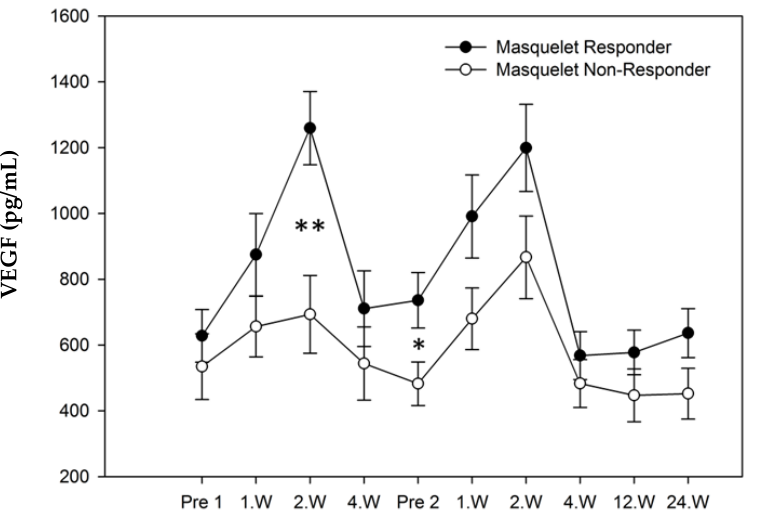
Figure 6. VEGF mean concentrations over time (error bars: standard error of the mean, * significant p < 0.05, ** very significant p < 0.01). Significant differences between both study groups in week 2 after step 1 and preoperative step